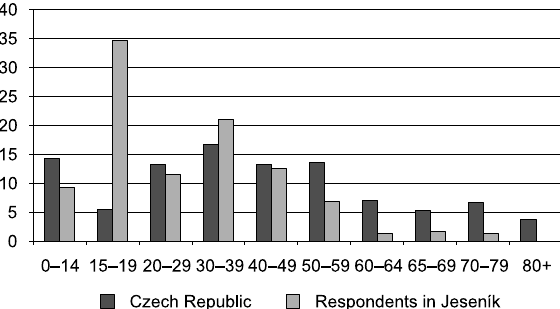
Fig. 3. Age distribution of overall population in the Czech Republic and age distribution of respondents in Jeseník. Data by Czech Statistical Office